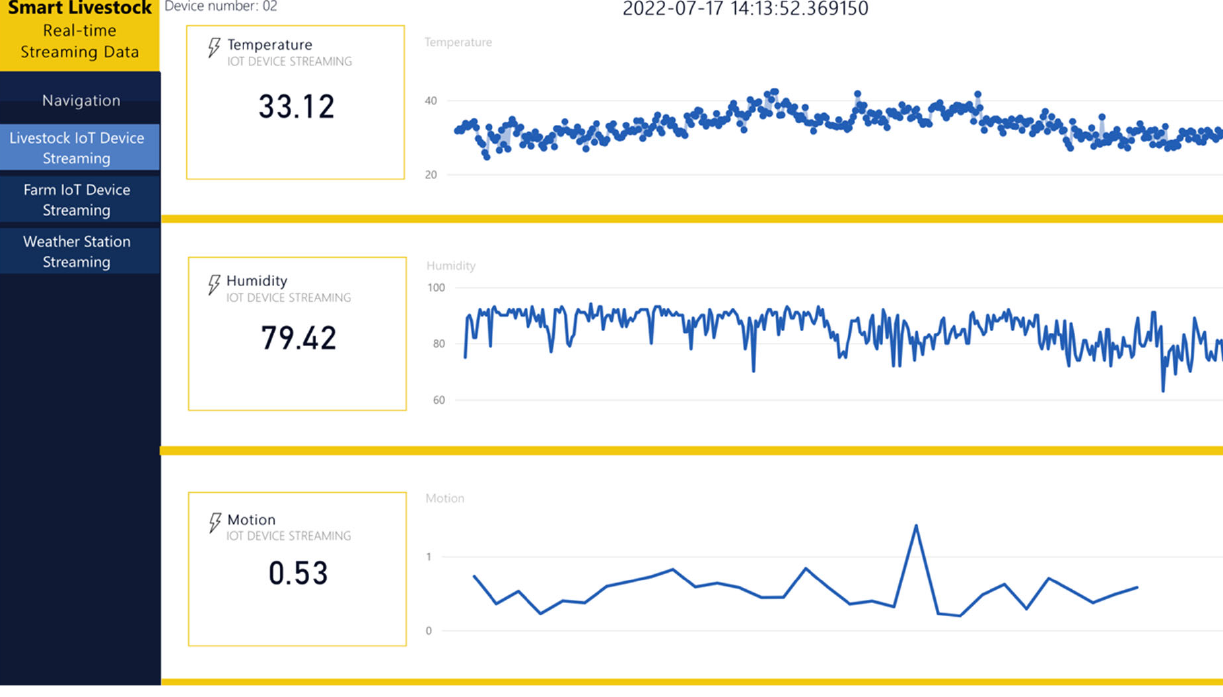
Figure 16. Real ‐ time report with data from livestock IoT device. Figure 16. Real-time report with data from livestock IoT